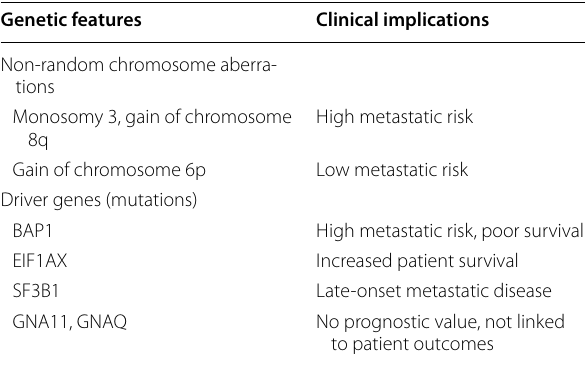
Table 3 Chromosome aberrations and driver mutated genes in uveal melanoma and their prognostic